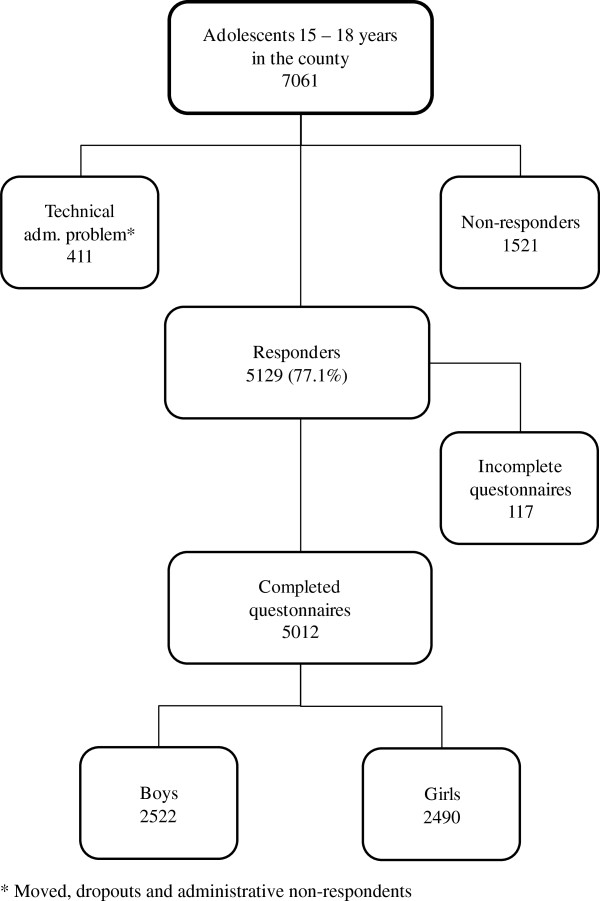
Flow chart of the study population.